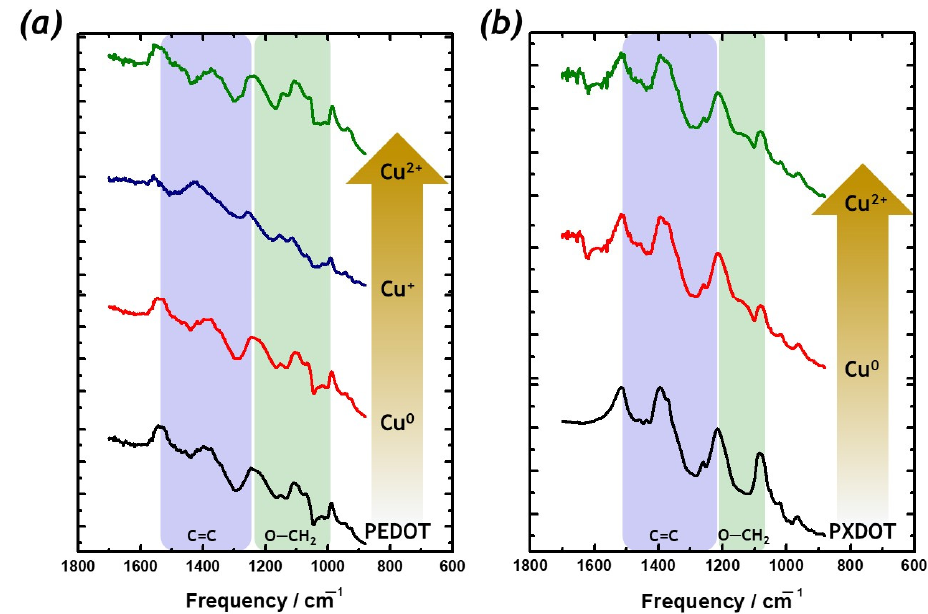
Figure 4. FTIR spectra of ( a ) PEDOT and ( b ) PXDOT films obtained before (black line) and after potentiostatic modification at different pulse potentials: − 0.4 V (red line), 0.15 V (blue line), and 0.4 V (green line). The accumulation of the metal ion was carried out under stirring for 120 s.